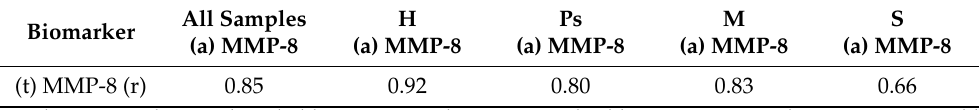
Table 2. Correlation between (a) and (t) MMP-8 disaggregated by diagnosis and severity.